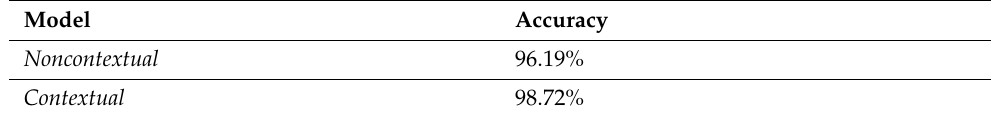
Table 6. Overall model